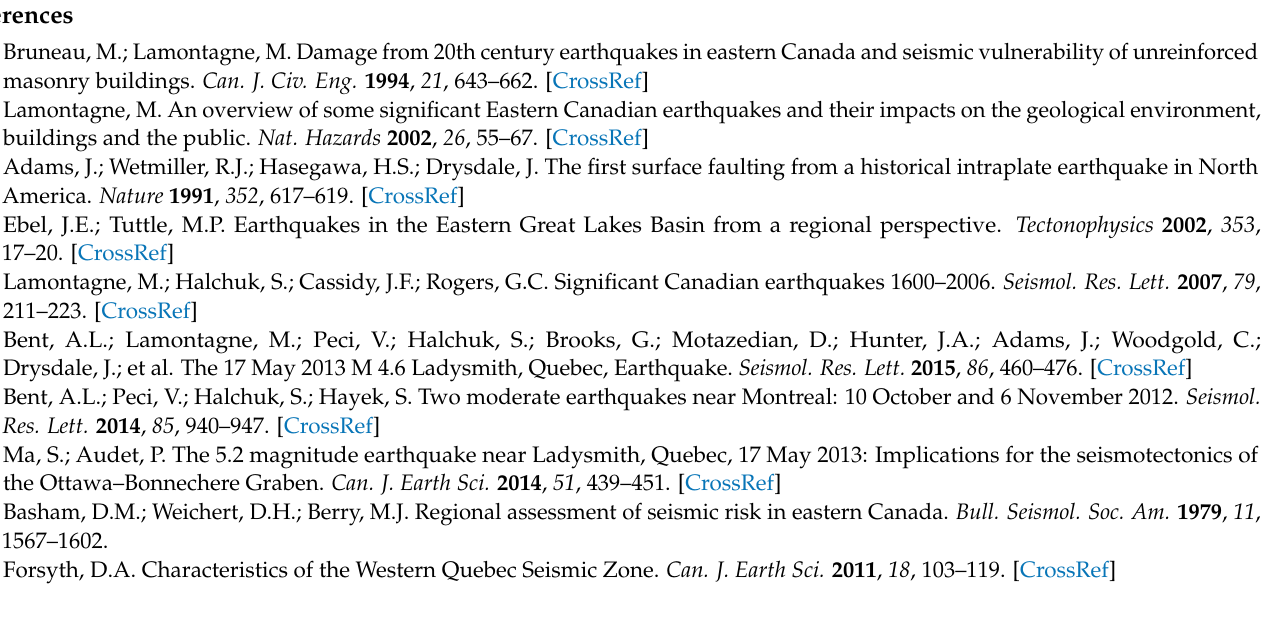
Table S2: Summary statistics for the spatial autocorrelation calculated with the Moran’s I Index [122]; Table S3. HI Values calculated for each geologic age identified for the 6 subset areas falling within the Ontario region; Table S4. HI Values calculated for each geologic age identified for the 3 subset areas falling within the Quebec region. Note that for the subset area 7 no geological information was found at the time of writing; Table S5. Summary Statistics for the lineaments identified across the seven subset